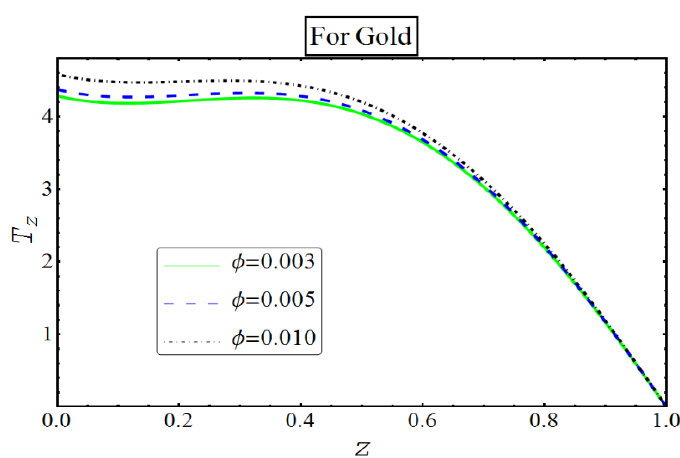
Figure 25. Variation of T z for the thermocapillary parameter.